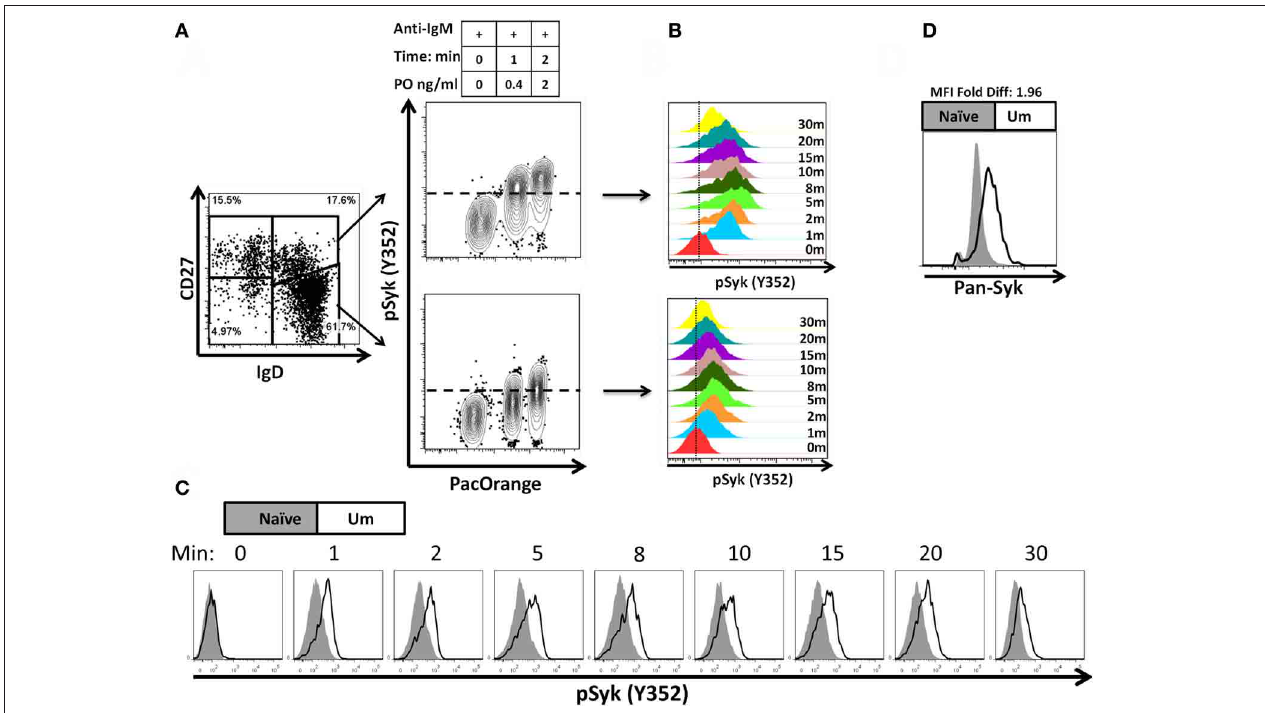
FIGURE 4 | Fluorescent-cell barcoding (FCB) and time course of Syk phosphorylation in naïve and Um B cells. FCB was introduced in the pacific orange channel (0, 0.4, and 2 μ g/ml) to enable assay multiplexing of 3 samples at a time (see details in “Materials and Methods”) and collected samples were deconvoluted for analysis (A) . Time course experiments of